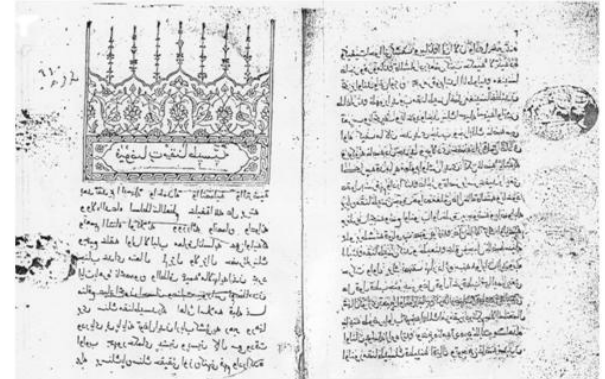
Figure 3a. Füyuzat-i Miknatissiye (The Benefits of the Compass) written by Ibrahim Müteferrika in 1731 (from Istanbul University Library).